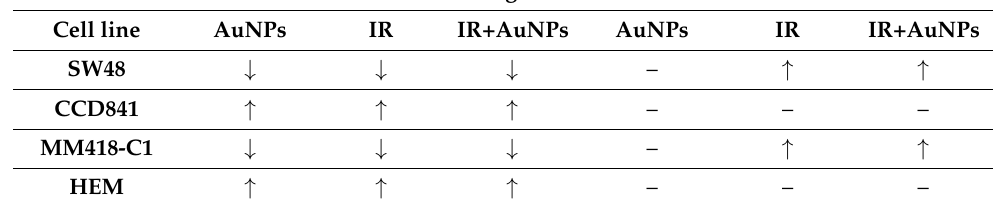
Table 1. The effect of IR and/or AuNPs on the migration and adhesion of SW48, CCD841, MM418- C1 and HEM cells. Changes due to treatment are shown as an increased effect ( ↑ ), decreased effect ( ↓ ) or no effect